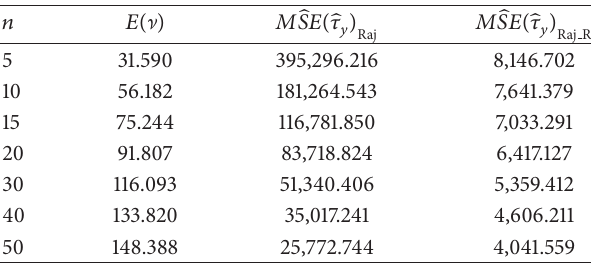
Table 4: The estimated MSE of the modified Des Raj estimators for the population total of the variable of